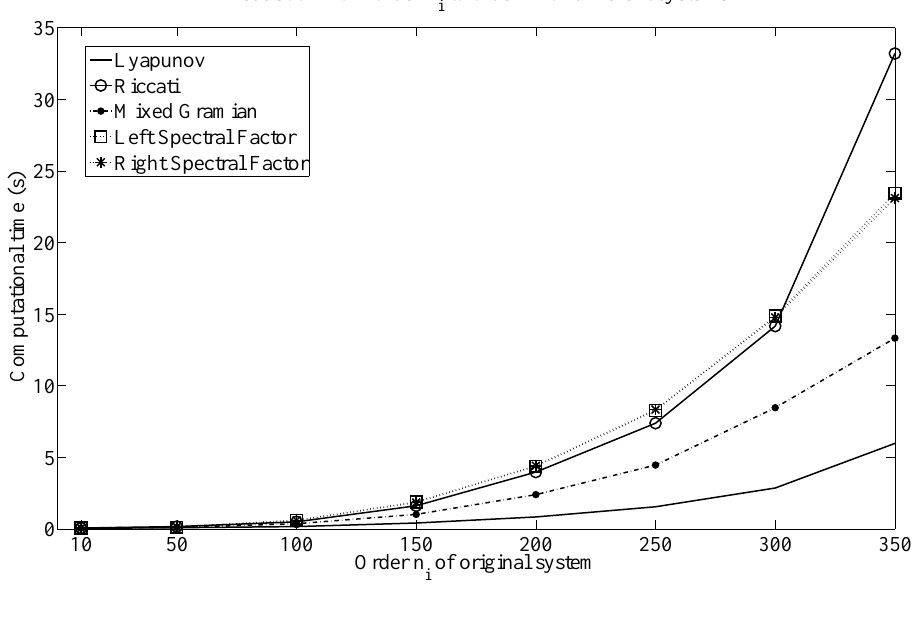
Figure 2: Computational time when reducing the original system of order n i down to order 2 for the different balancing